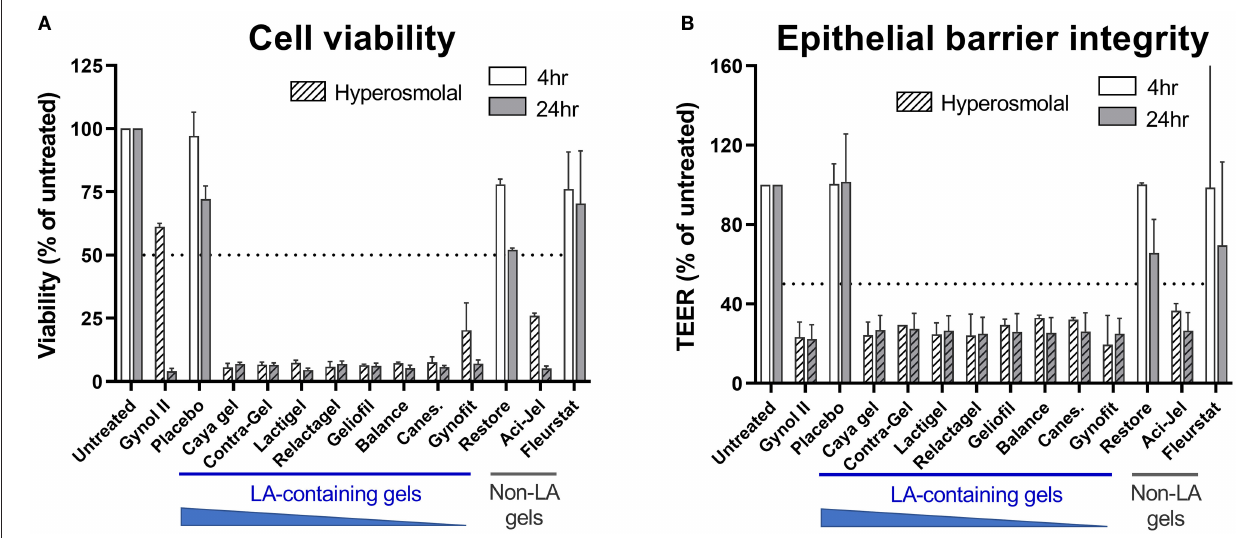
FIGURE 1 | Effects of lactic acid (LA)-containing gels on vaginal epithelial cell viability and integrity. The EpiVaginal tissue model was treated with 11 over-the-counter (OTC) vaginal gels, the positive control gel Gynol II or a hydroxyethyl cellulose placebo gel as indicated. Cell viability (A) was assessed by MTT assay and epithelial barrier integrity (B) measured by transepithelial electrical resistance (TEER) at 4 or 24h after gel addition. Hashed bars indicate hyperosmolal gels. A and B show mean and standard deviation of data derived from n = 2 independent experiments with 3 individual tissue replicates per treatment included in each assay. Values below 50% of untreated (indicated by dotted line in graphs) is considered a substantial